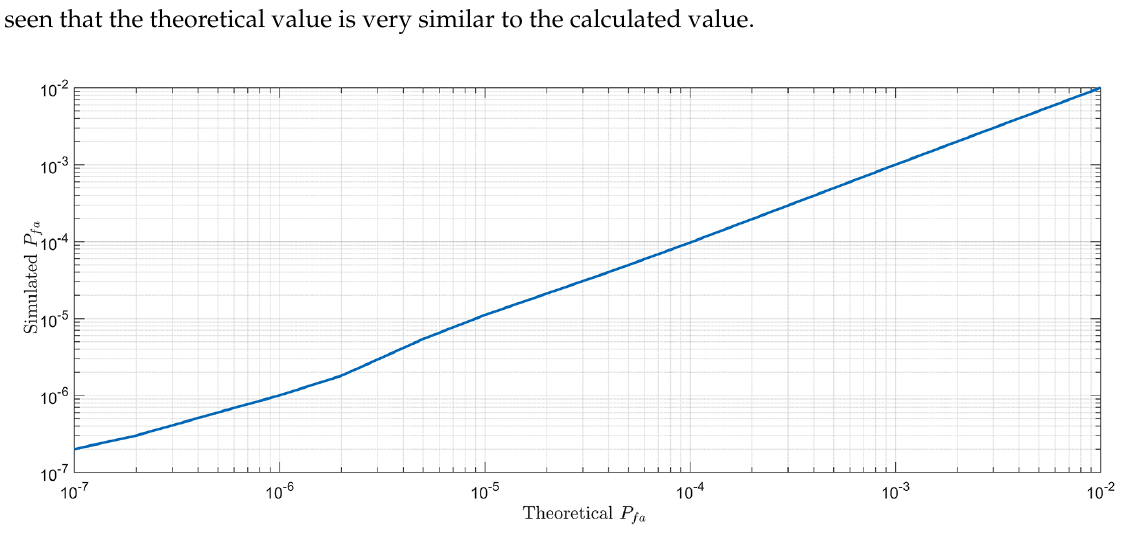
Figure 11. The false alarm rate